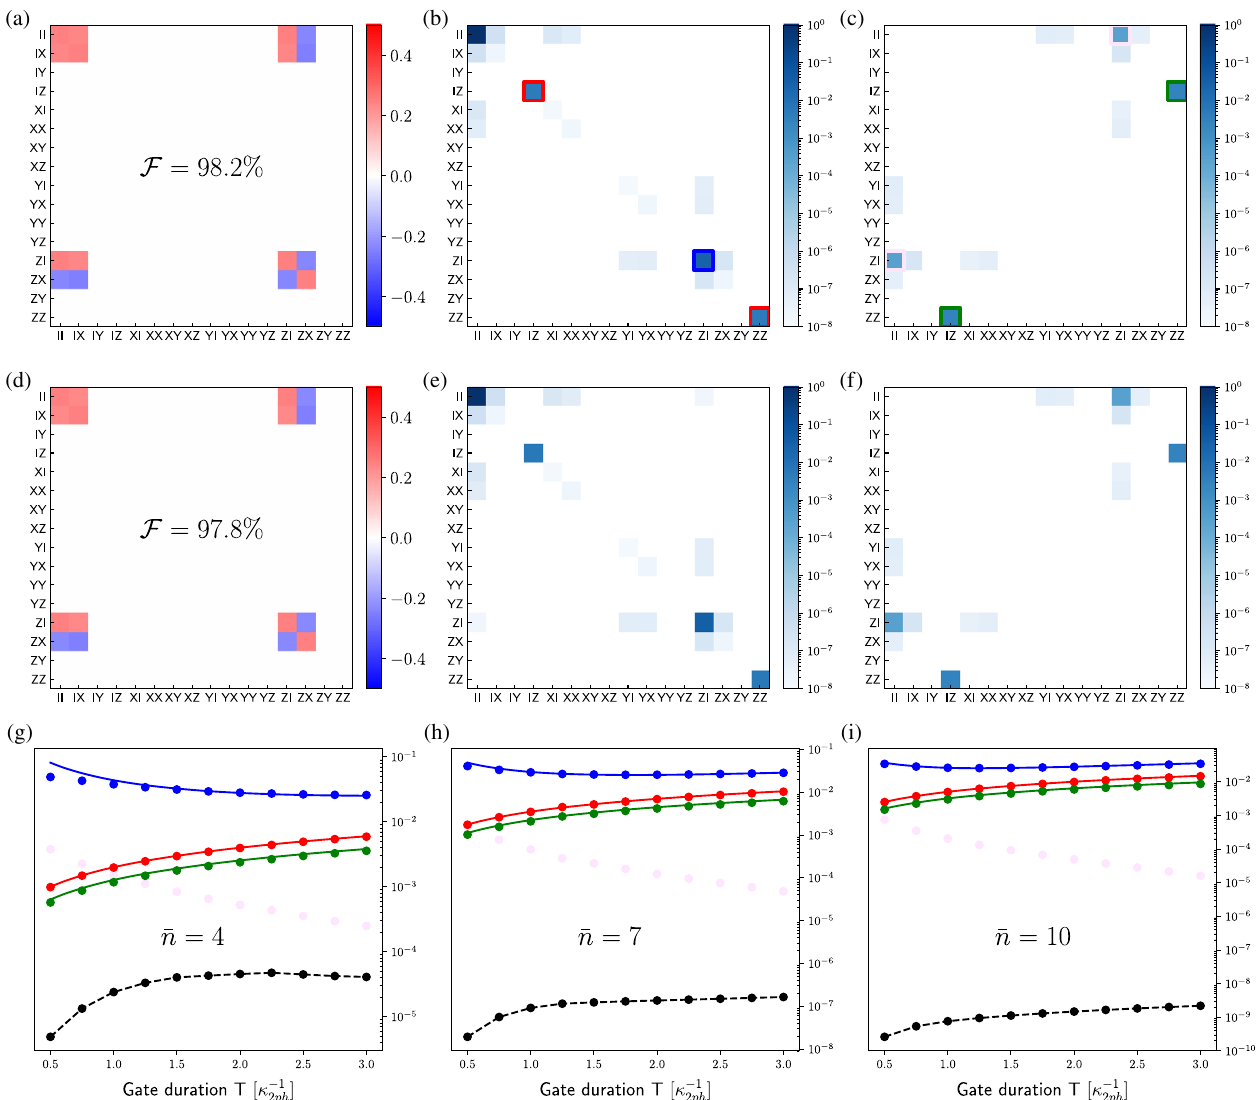
FIG. 10. Process tomography of the CNOT gate in the presence of noise. The CNOT process presented in Sec. IV is numerically simulated for ¯ n ¼ 7 photon cat qubits using two different error models. First, we consider photon loss on both modes κ 1 κ D ½ ˆ b (cid:3) (a) – (c). Then, we consider a more elaborate error model including photon loss κ 1 ph